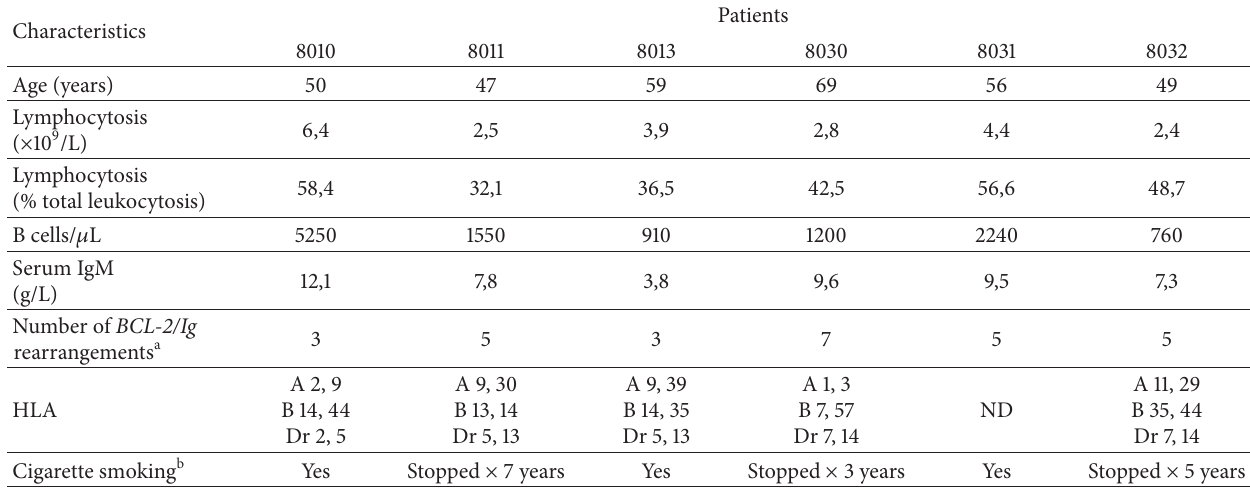
Table 1: Clinical data of PPBL